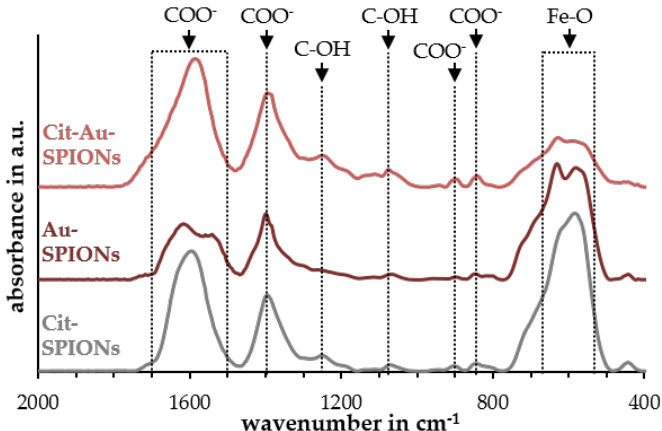
Figure 3. FTIR spectra of Cit-SPIONs, Au-SPIONs and Cit-Au-SPIONs. Peak identification was performed using [36-40].